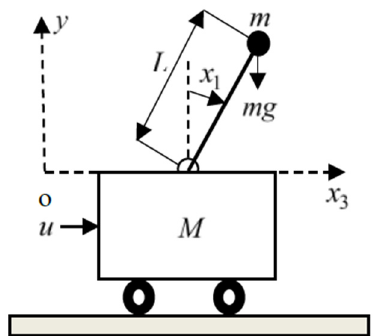
Figure 1. The inverted pendulum system.